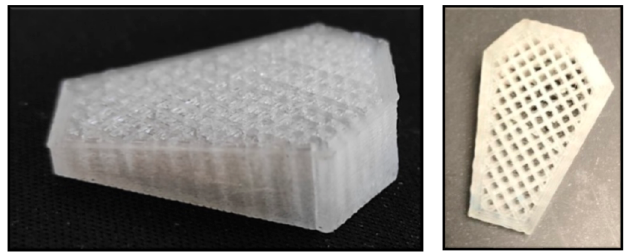
Figure 1. PLA implants.